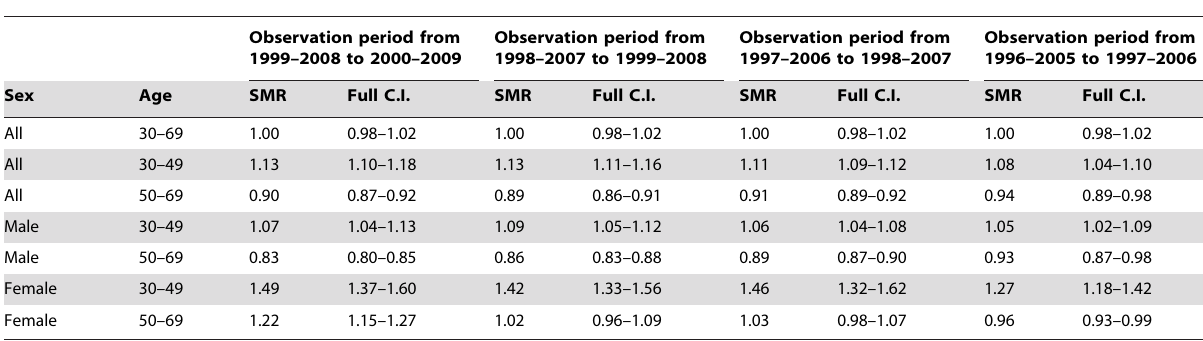
Table 6. Four proposed 10-year observation periods, with one year of daily re-sampling